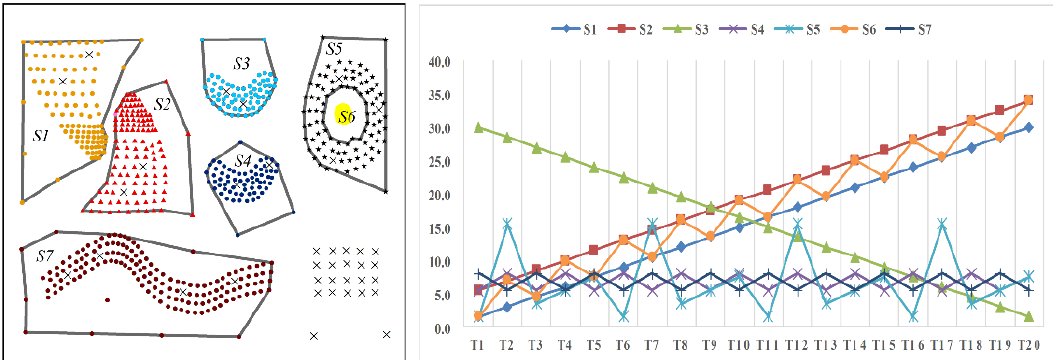
Figure 5. Time series attribute distribution of objects in 𝑆1 and the mean value of attributes in every area.